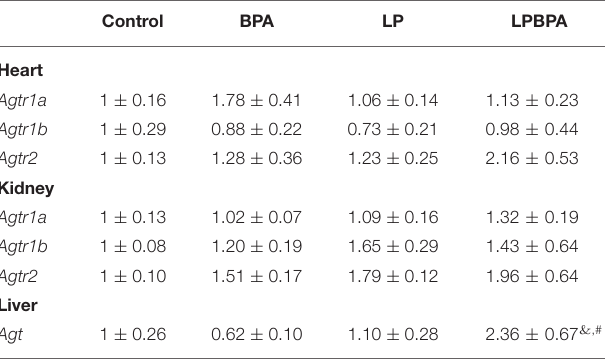
TABLE 1 | Renin-angiotensin system gene expression in mice following postweaning low-protein diet (LP) and/or bisphenol A (BPA) exposure.